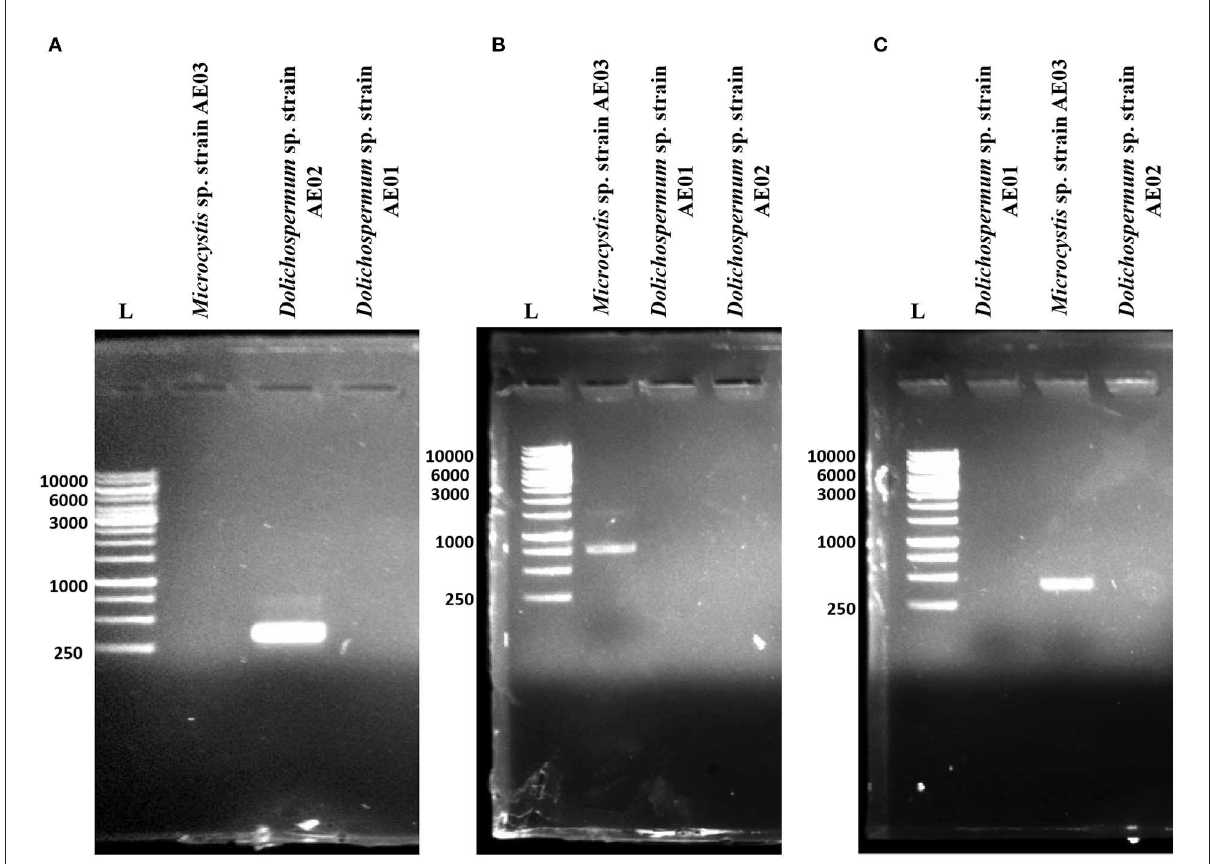
FIGURE4 PCR amplification of targeted toxin genes responsible for (A) anatoxin ( anaC ), (B) microcystin ( mcyB ), and (C) cylindrospermopsin (polyketide synthetase, pks ) production in the isolated cyanobacterial strains from Dal Lake, Kashmir. L: 1kb DNA